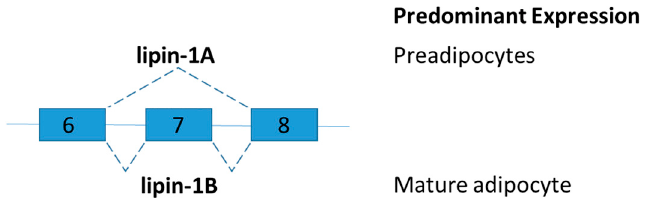
Figure 5. Schematic figure representing lipin splice variants. Lipin-1B differs from lipin-1A by the presence of exon 7. The isoforms of LPIN1 serve distinct functions in adipocytes.